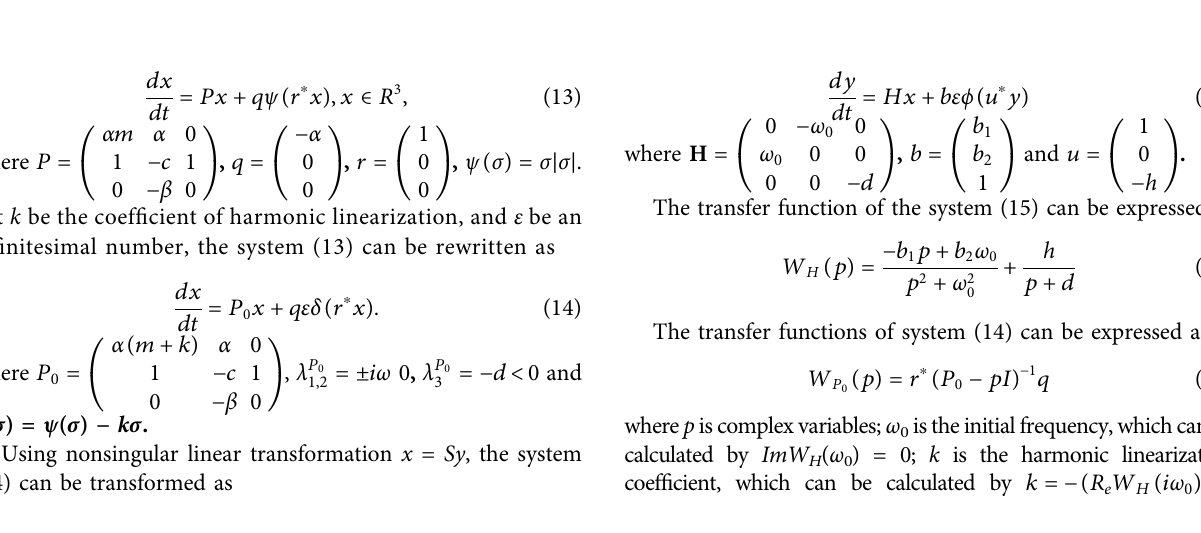
FIGURE 2 | Basin ofattractions of the system with different α and in different planes. (A) α (cid:1) 50, z 0 (cid:1) − 1, and x 0 − y 0 plane; (B) α (cid:1) 50, y 0 (cid:1) − 0.1, and x 0 − z 0 plane; (C) α (cid:1) 50, x 0 (cid:1) 0.3, and y 0 − z 0 plane; (D) α (cid:1) 69, z 0 (cid:1) − 1, and x 0 − y 0 plane; (E) α (cid:1) 69, y 0 (cid:1) 0.1, and x 0 − z 0 plane; (F) α (cid:1) 69, x 0 (cid:1) 0.3, and y 0 − z 0